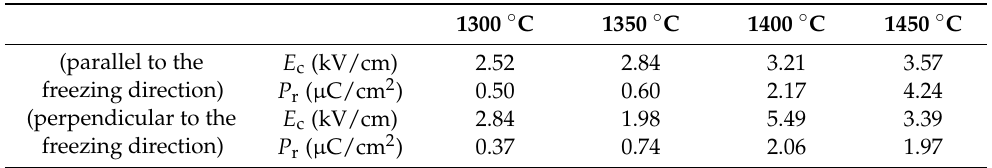
Figure 8. Ferroelectric hysteresis loops of porous BCZT piezoelectric ceramics sintered at different temperatures ( a ) parallel to the freezing direction, ( b ) perpendicular to the freezing direction. Table 1. Effect of sintering temperature on the coercivity field and remnant polarization intensity for the porous BCZT piezoelectric